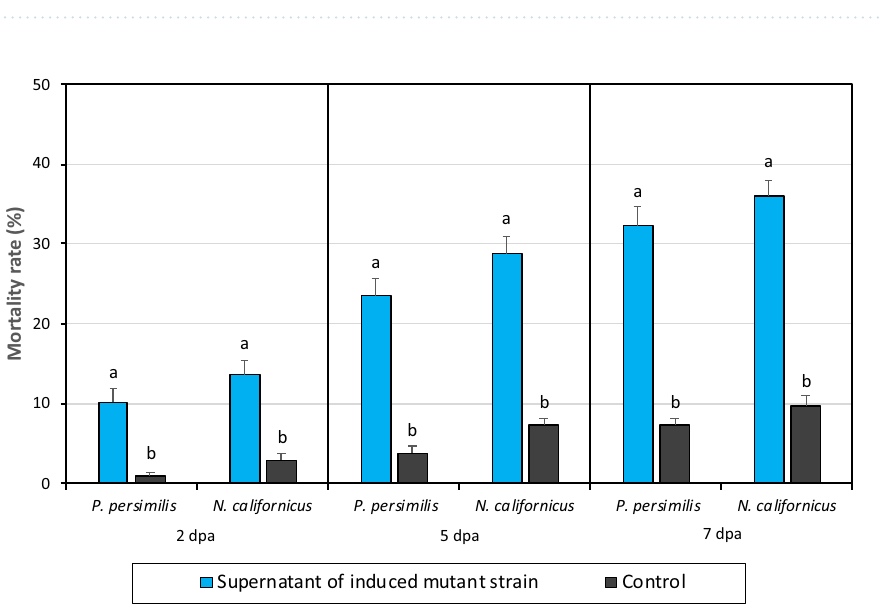
Figure 5. The toxicity of cell free supernatant produced by induced Xenorhabdus nematophila (pCEP_kan_ XNC1_1711) mutant strain on adult female of Phytoseiulus persimilis and Neoseiulus californicus